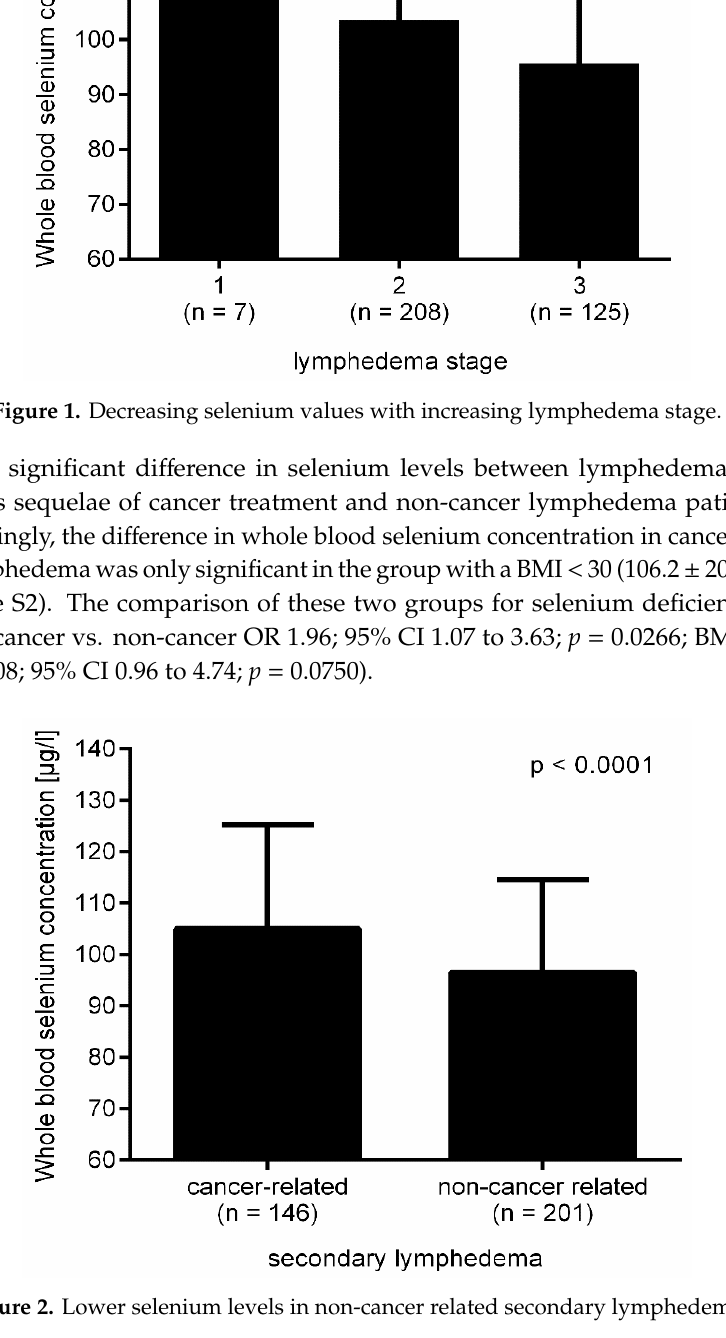
Figure 2. Lower selenium levels in non-cancer related secondary lymphedema.